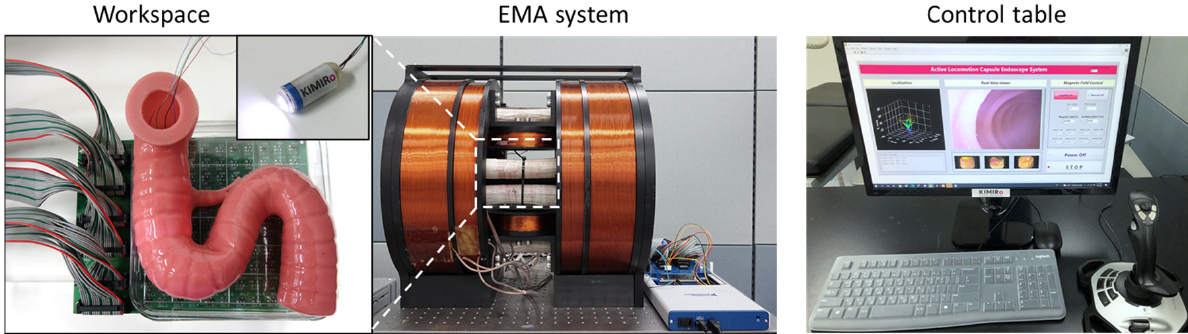
Figure 6. Photoshoot of the real experiment setting.